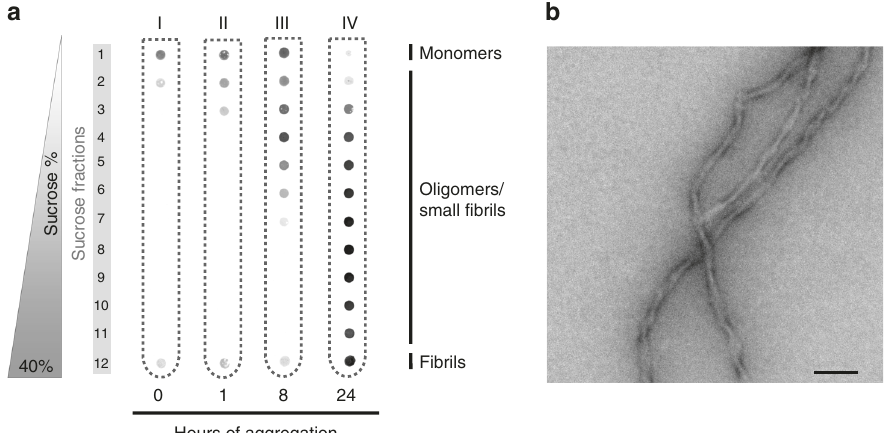
Fig. 1 Precise control of Tau aggregation. a Time course of Tau-RD* aggregation monitored by density gradients. Samples were centrifuged for 2.5 h at 200,000× g . b Transmission electron microscopy of Tau-RD* fi brils, timepoint 24 h. Scalebar 100